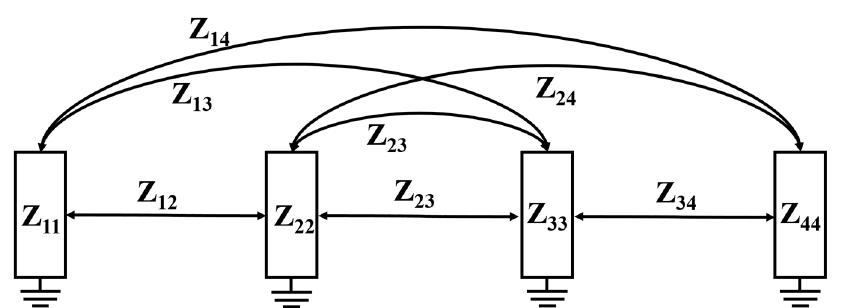
Figure 7. Impedance model of 1 × 4 array.